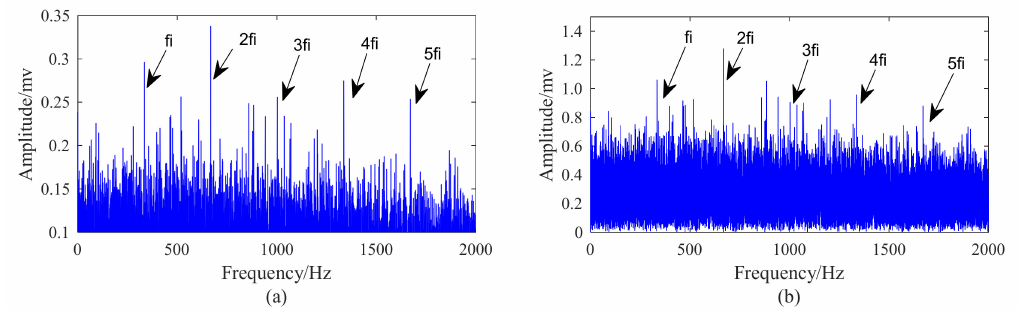
Figure 17. The diagnosis result obtained by IMF3 of the simulation signal of the bearing with the inner race fault: ( a ) the squared envelope spectrum of IMF3; ( b ) the teager energy spectrum of